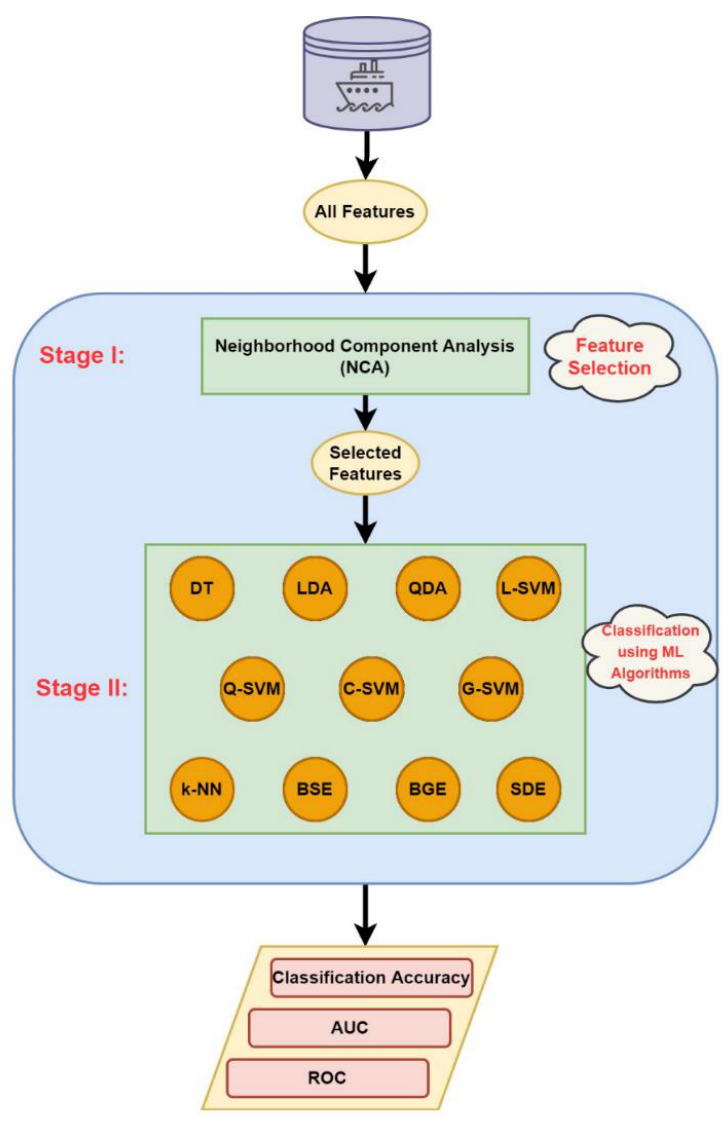
Figure 3. Workflow diagram for our proposed two-stage ML approach .